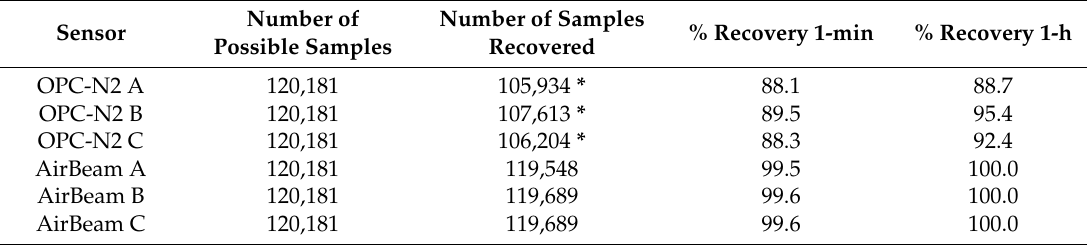
Table 5. Data recovery for the sensors from 14 April 2016, through 6 July 2016.